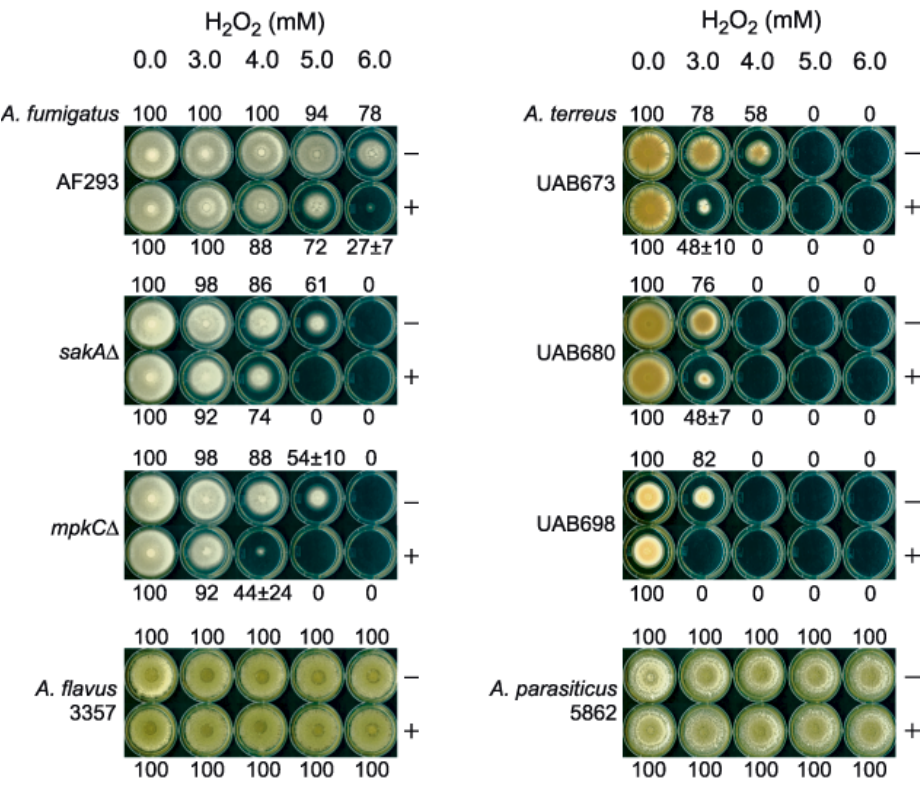
H O tested against Aspergillus strains. Numbers (0–100) indicate percent (%) radial 2 2 growth compared to non-treated control (100%; no H (+), w/ KA (5